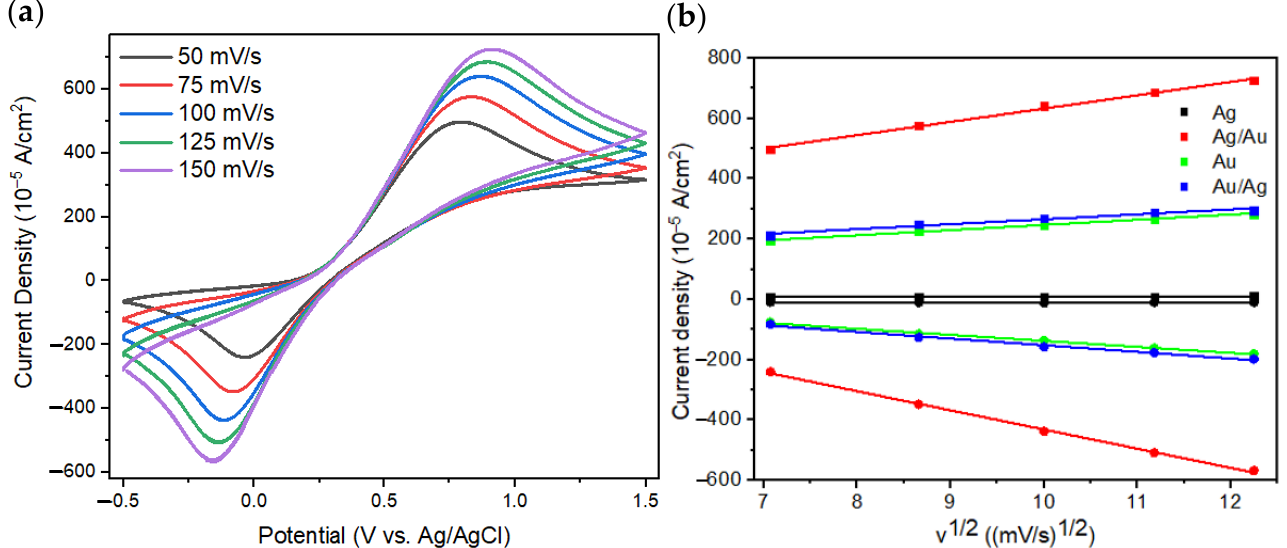
Figure 5. ( a ) The result of the CV test using varying scan rates on the Ag/Au thin film; ( b ) oxidation peak (represented in squares) and reduction peak (represented in circles) of the Ag, Ag/Au, Au, and Au/Ag thin films.